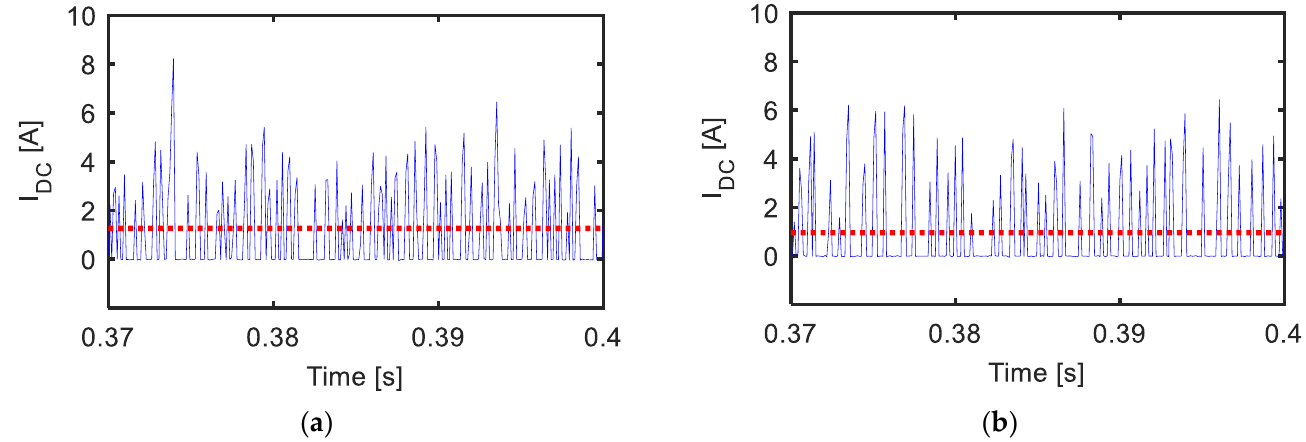
Figure 11. The drive total losses at different DC-link voltages and different motor currents and cur- rent angles of ( a ) 50° and ( b ) 25°.